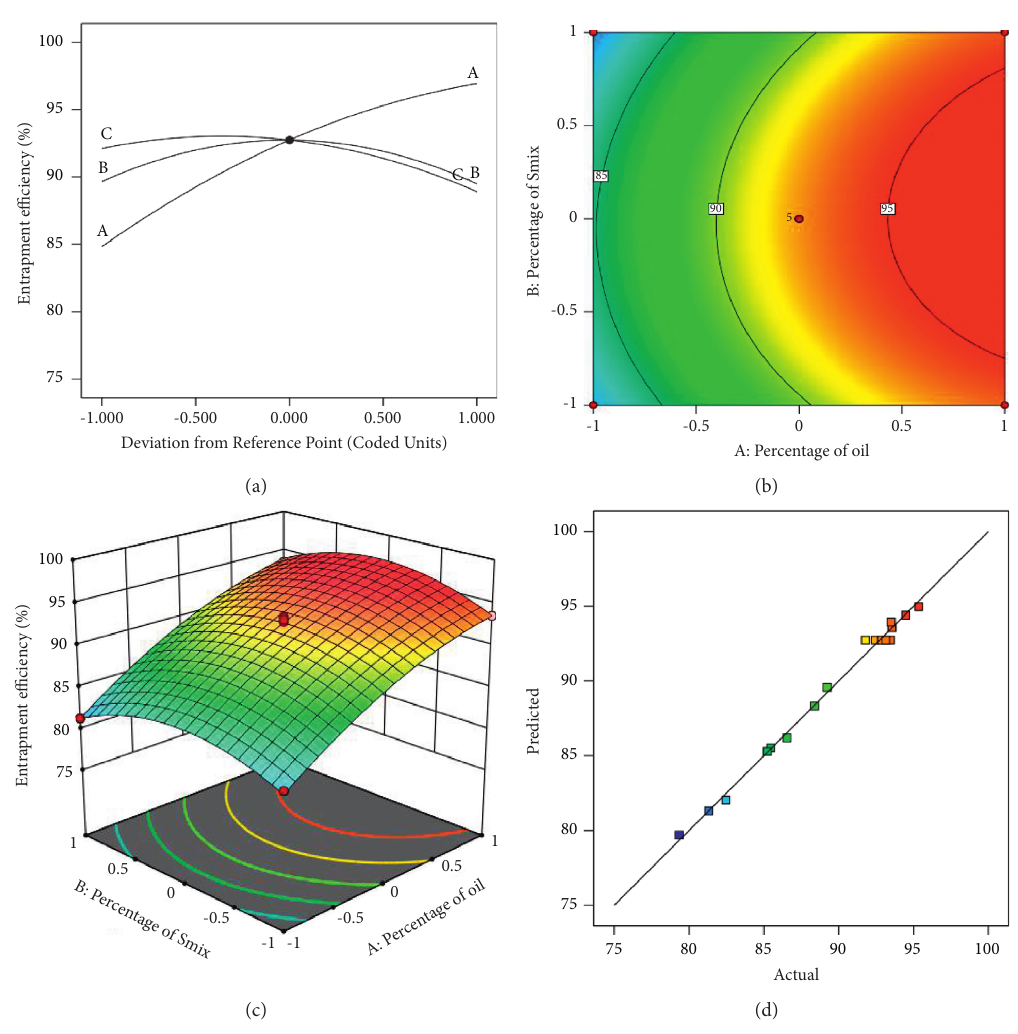
Figure 2: Consequence of independent variables on entrapment efficiency. Results were presented in the (a) perturbation plot, (b) contour plot, (c) 3D surface plot, and (d) predicted versus actual